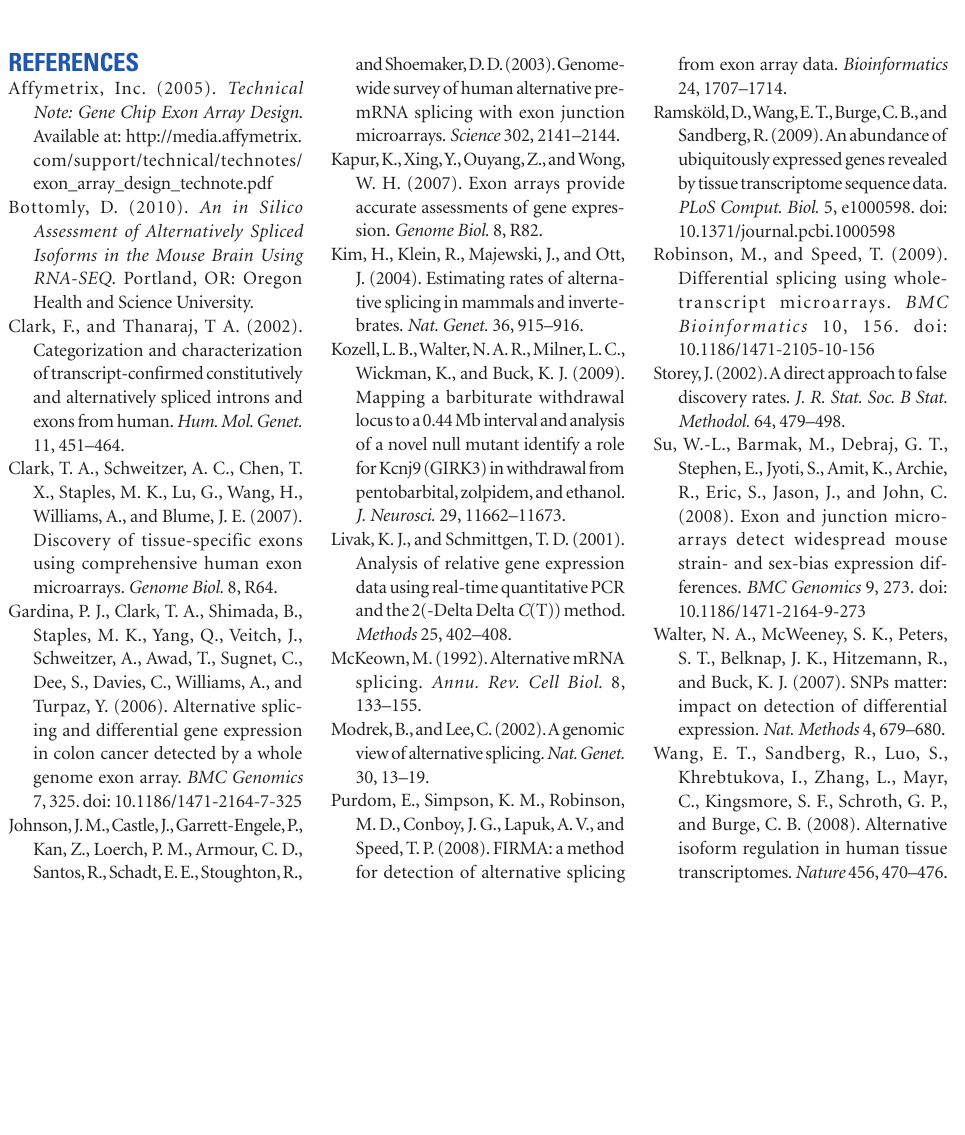
Table S1 | Putative strain-specific Aeu candidates identified by transcript- based statistical modeling and annotation of exon-level model. qStrain/exon indicates the q -value for the strain–exon interaction. SNP-affected indicates that at least one probeset in the transcript was affected by a SNP in the masking procedure. ASTD event indicates a transcript was involved in a comparison of at least one AEU event. Single-mapped exon transcripts (that is, transcripts that only contained one exon in core and in our mapping) are also provided. (please see attached file Supplemental_Table 1.xls) Table S2 | Putative strain-specific Aeu candidates identified by probeset- level model. Results are similar to Table S1 in Supplementary Material, except that the interaction term of interest is qStrain. Probeset, and that the model includes extended and full